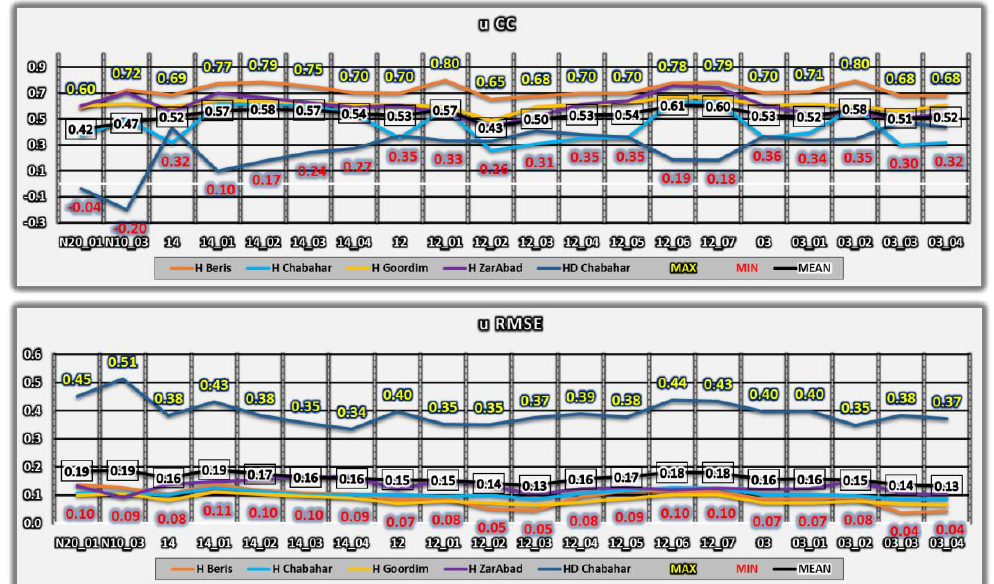
Figure7. Correlation coefficient and RMSE of surface u-velocity component for model results